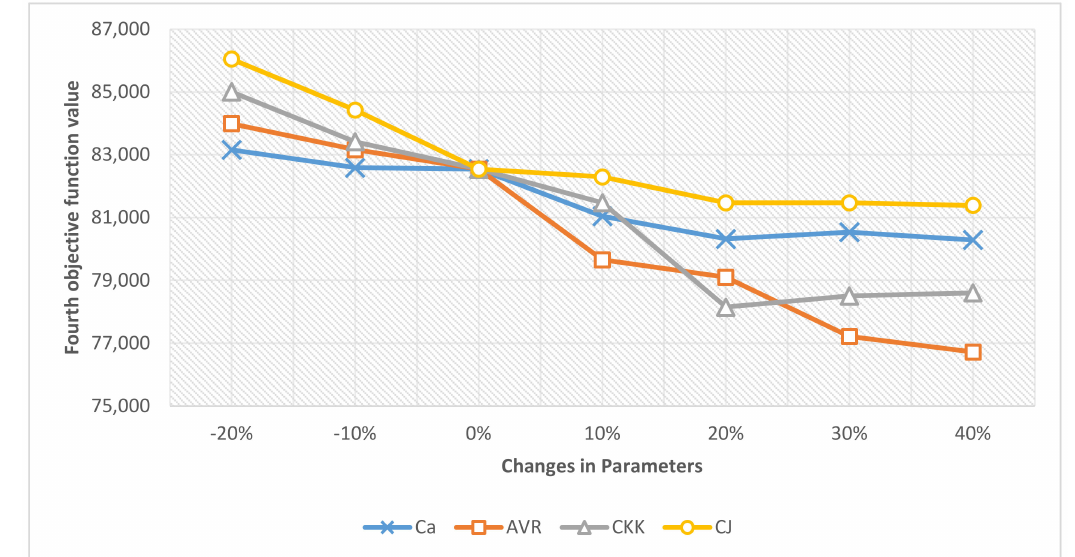
Figure 13. Sensitivity analysis of the fourth objective function by changing the important